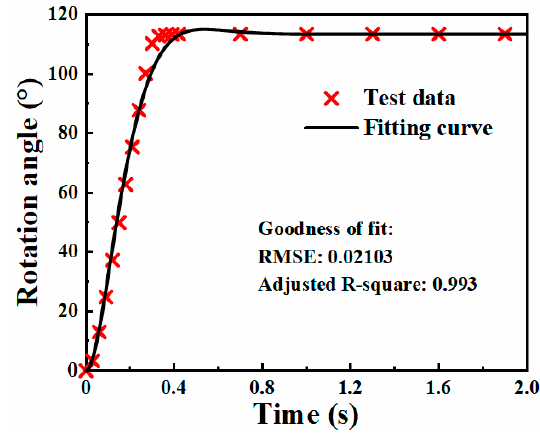
Figure 16. Step response curve of the servo motor.